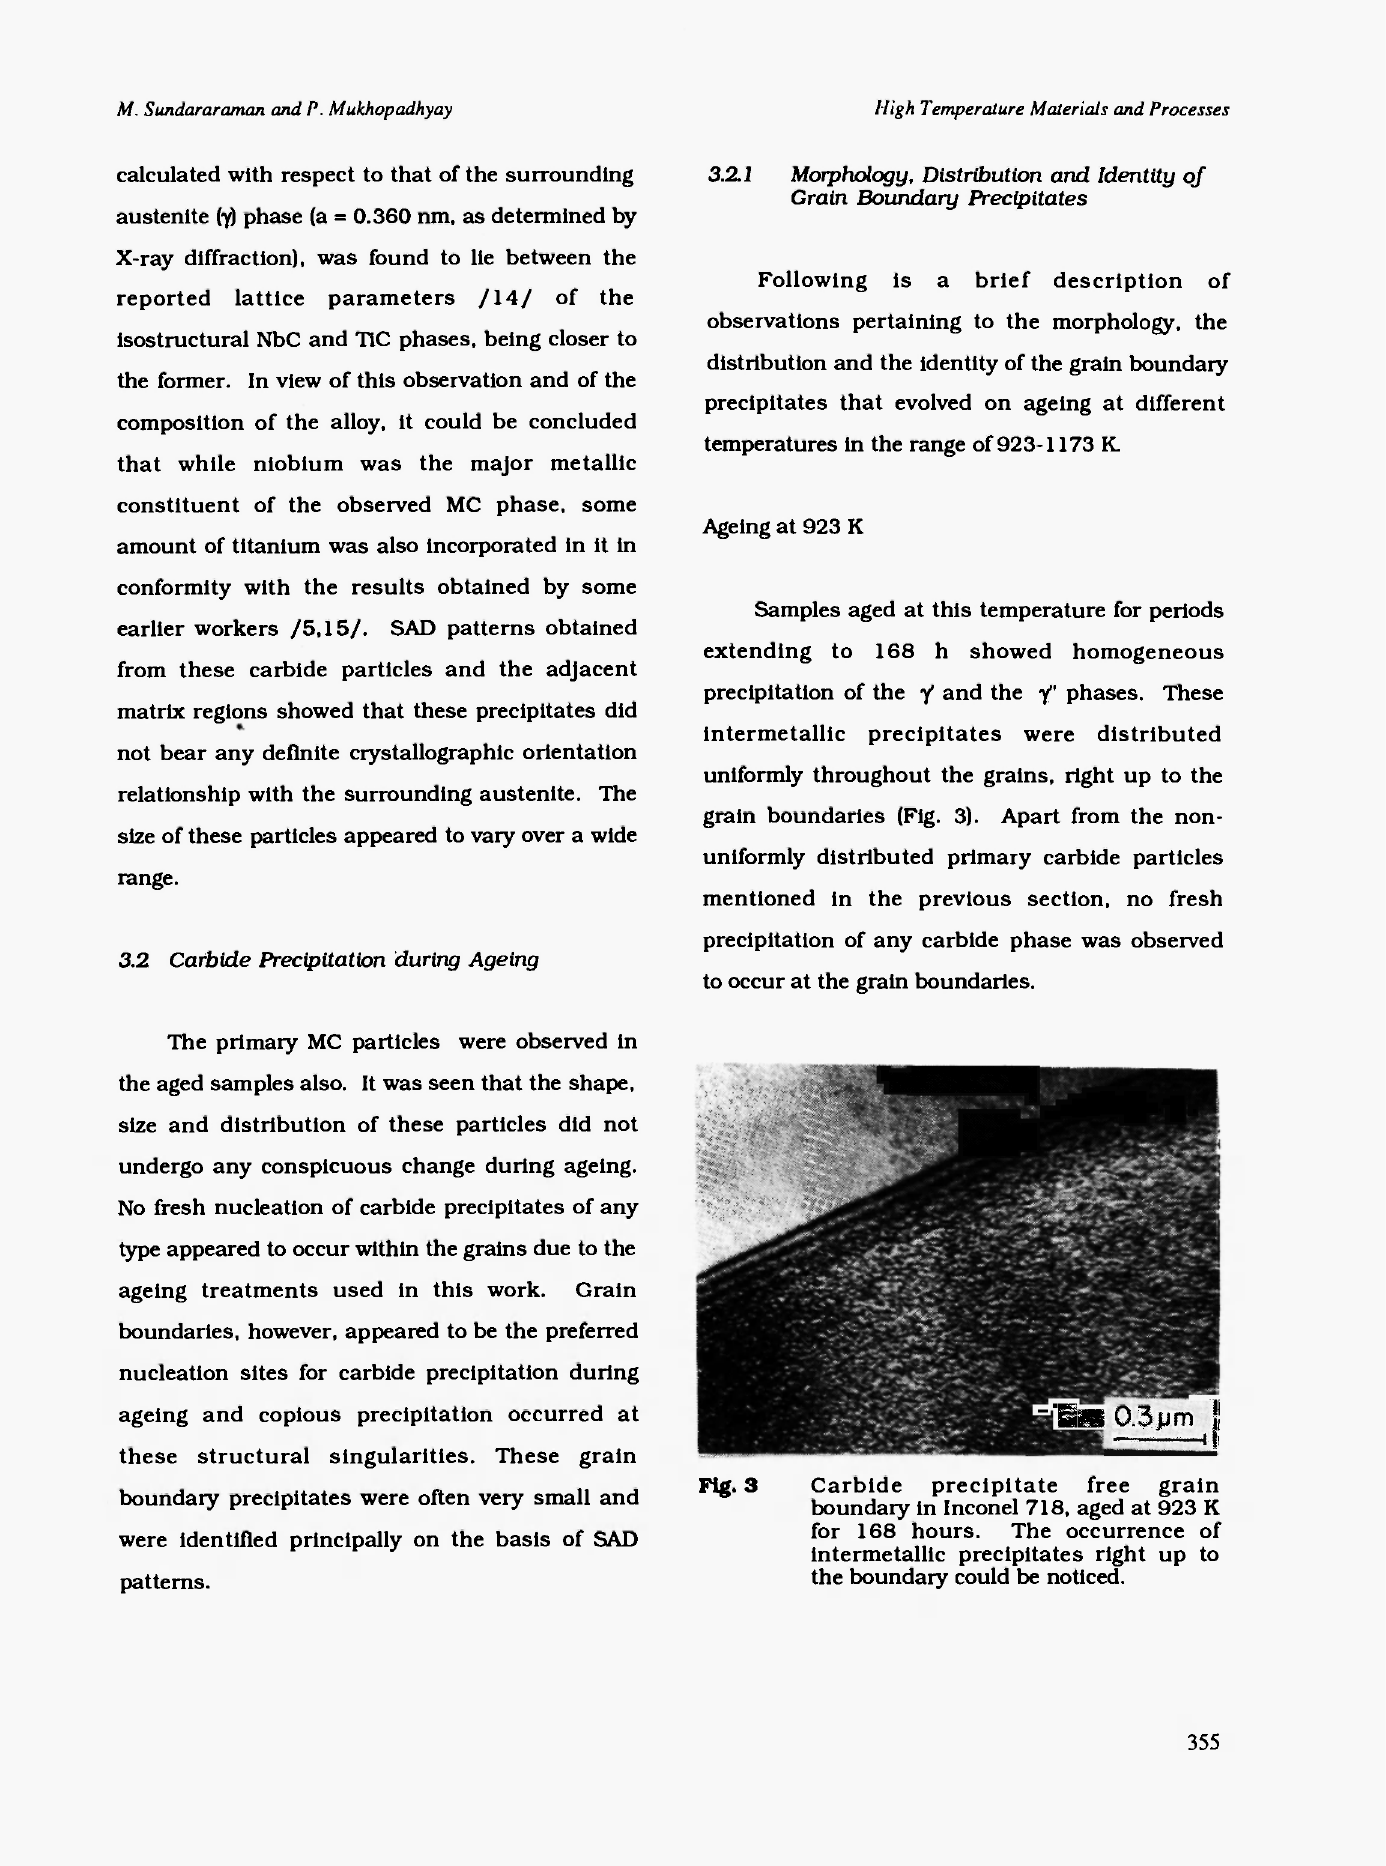
Fig. 3 Carbide precipitate free grain boundary in Inconel 718, aged at 923 Κ for 168 hours. The occurrence of intermetallic precipitates right up to the boundary could be